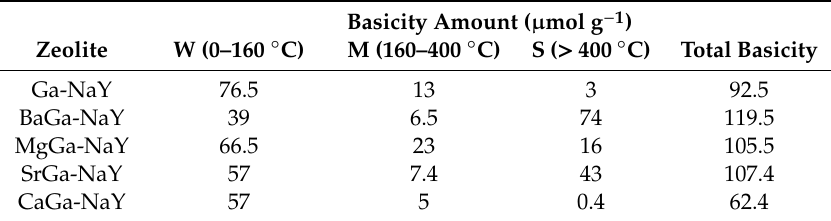
Table 3. Base properties of different zeolites studied by CO 2 -TPD.